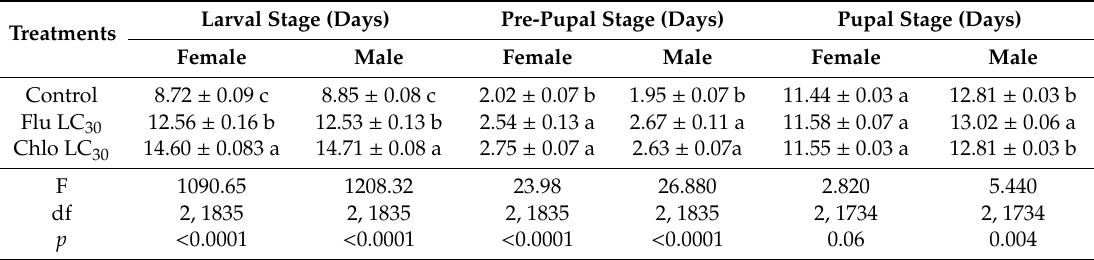
Figure 1. Survival (%) of Chloridea virescens larvae (mean ± SE) when exposed for 7 days on treated diet (black bars) with sublethal concentrations of flubendiamide (Flu) and chlorantraniliprole (Chlo), and after feeding on untreated diet four additional days (grey bars). The corresponding sample sizes were: Control (950, 775), flubendiamide (390, 296), and chlorantraniliprole (1210, 775). Mean survival with di ff erent letters within the same color of bars are significantly di ff erent (Tukey test, p < 0.05). Table 2. Sublethal e ff ects of flubendiamide (Flu) and chlorantraniliprole (Chlo) on larval, pre-pupal, and pupal development time of Chloridea virescens under controlled laboratory environmental conditions (25 ± 2 ◦ C, 60 ± 10% RH, and 14L: 10D).